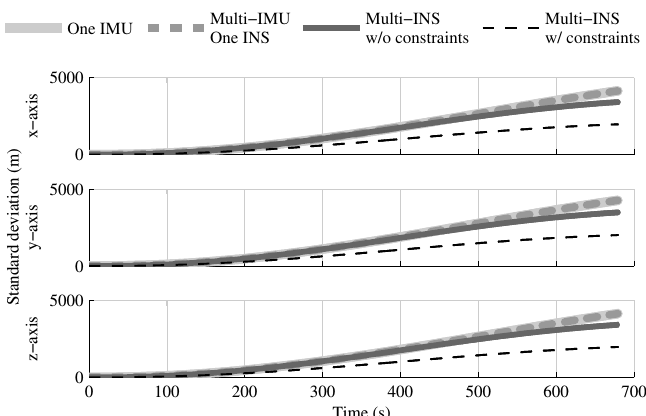
Figure 12. The position estimation error standard deviation obtained with the navigation solutions, when the GPS receiver is not present.